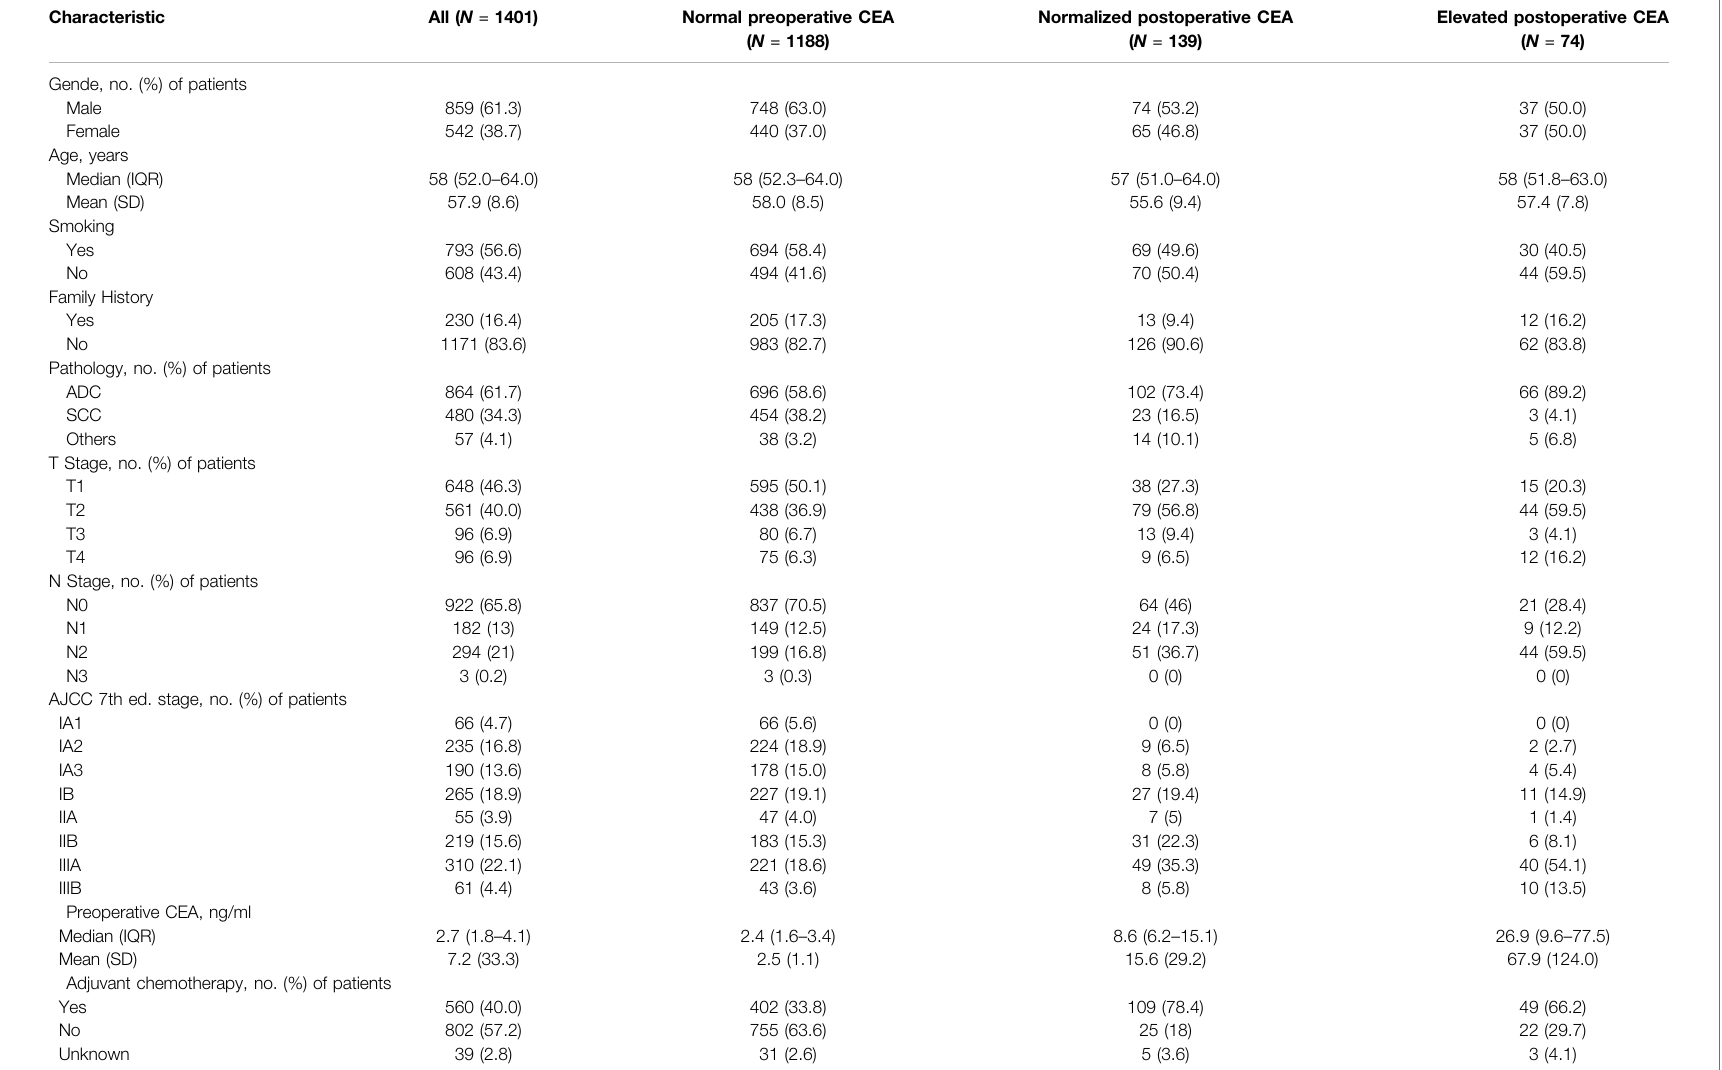
TABLE 1 | Patient and tumor characteristics.